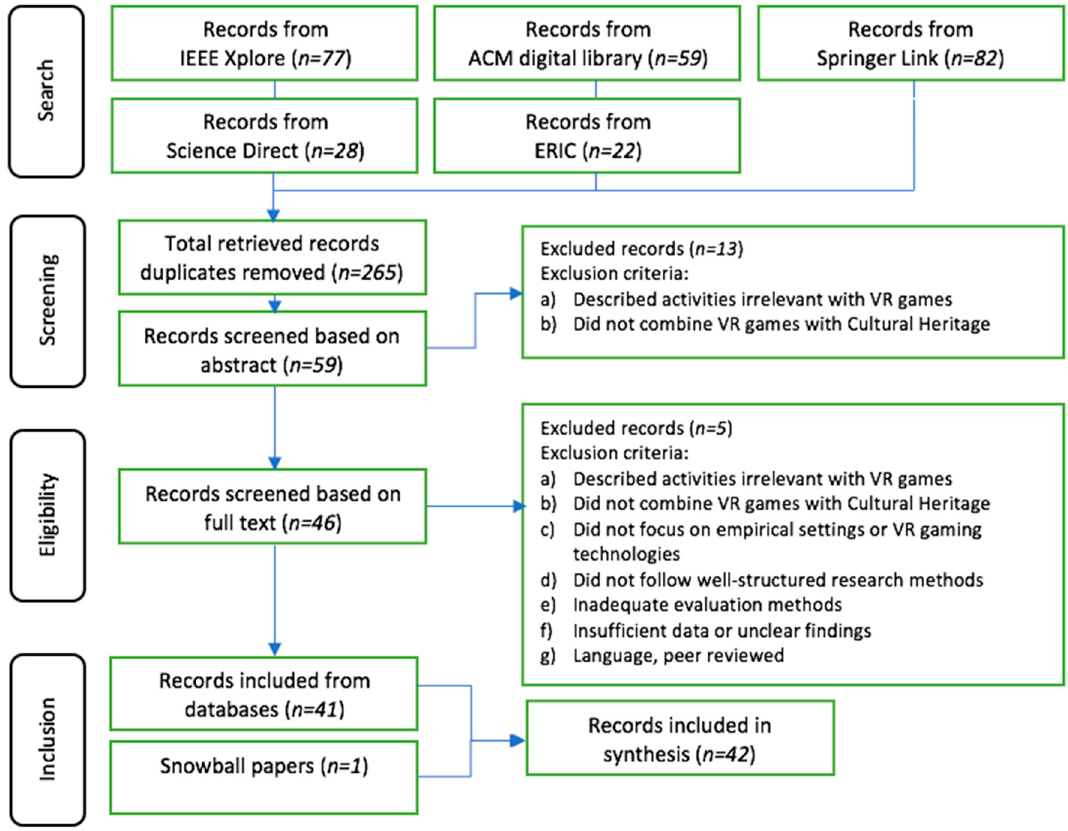
Figure 2. Flow of information through the different phases of this review (Prisma flowchart [33]).